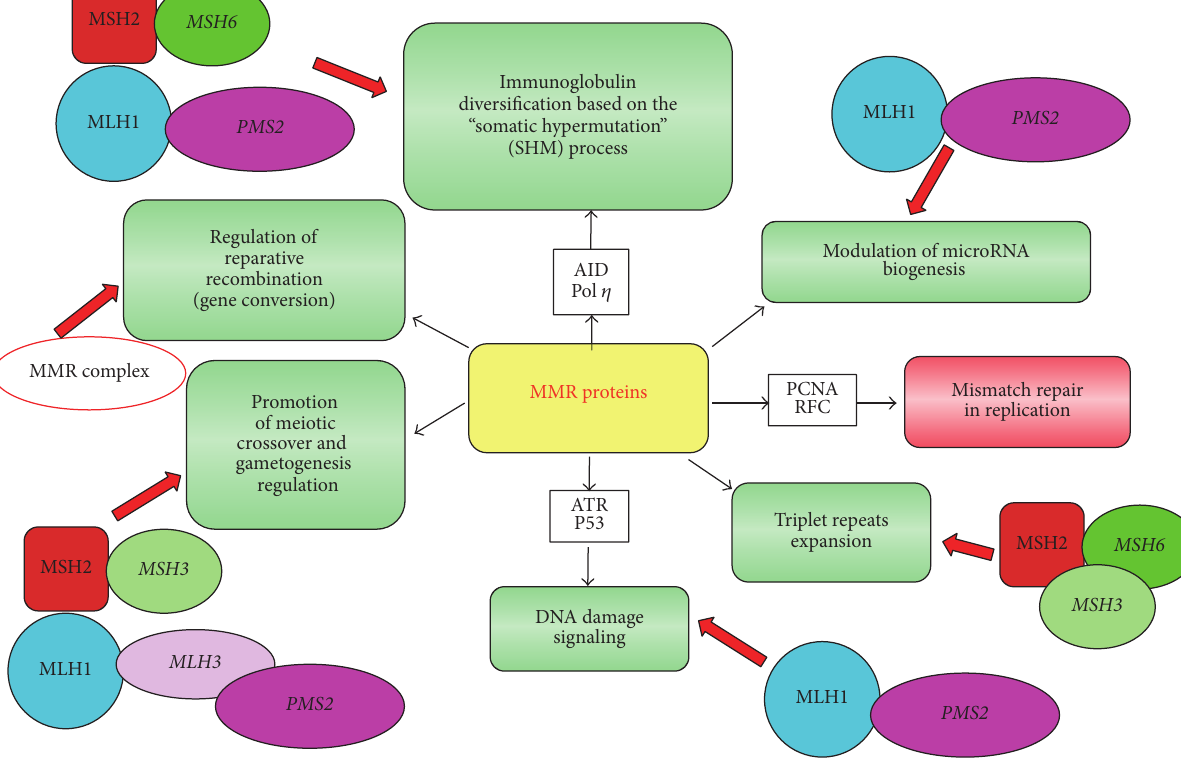
Figure 1: New role for MMR